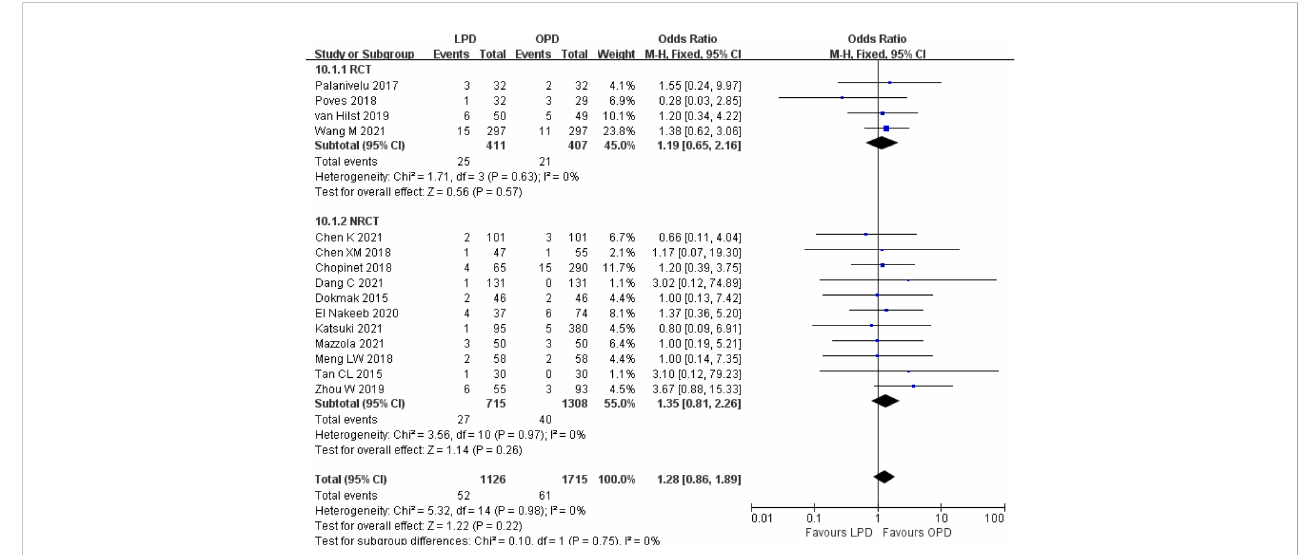
FIGURE 10 Forest plot of comparison between LPD and OPD on bile leak. LPD, laparoscopic pancreaticoduodenectom; OPD, open